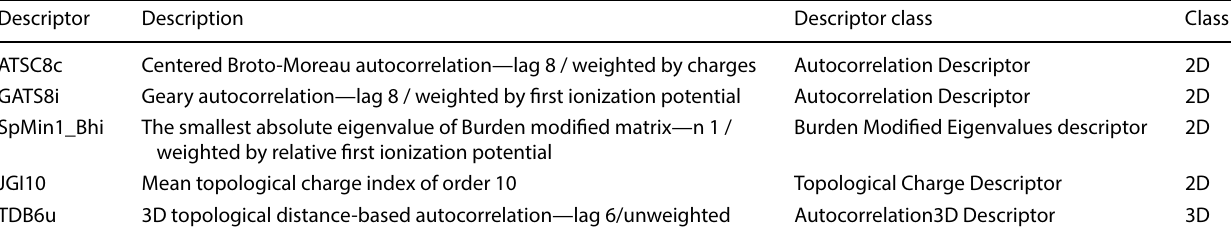
Table 3 Contributive descriptors in the selected model, their meaning as well as their classes